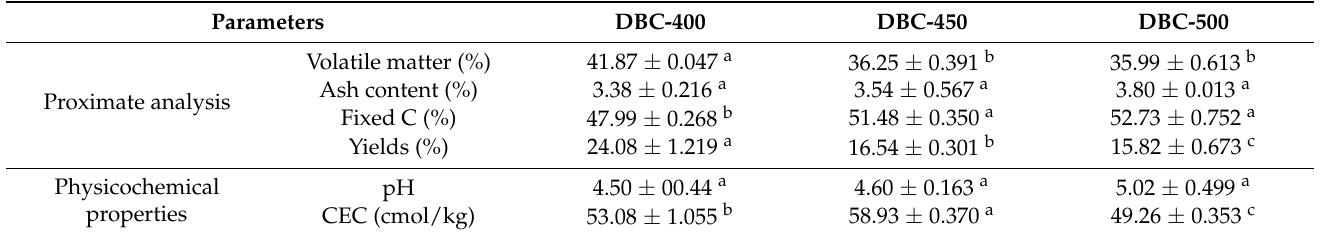
Table 1. Volatile matter, ash, fixed C, yields, pH, and CEC of DBC biochar obtained from different